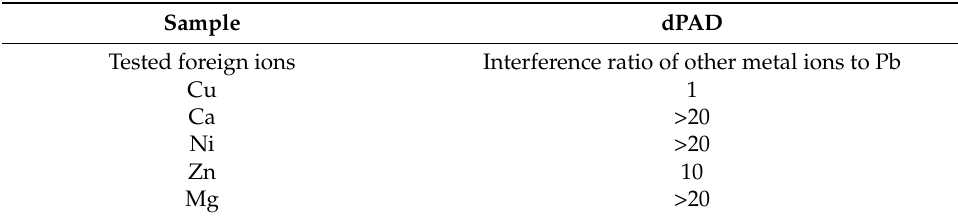
Table 1. Interference ratio of foreign